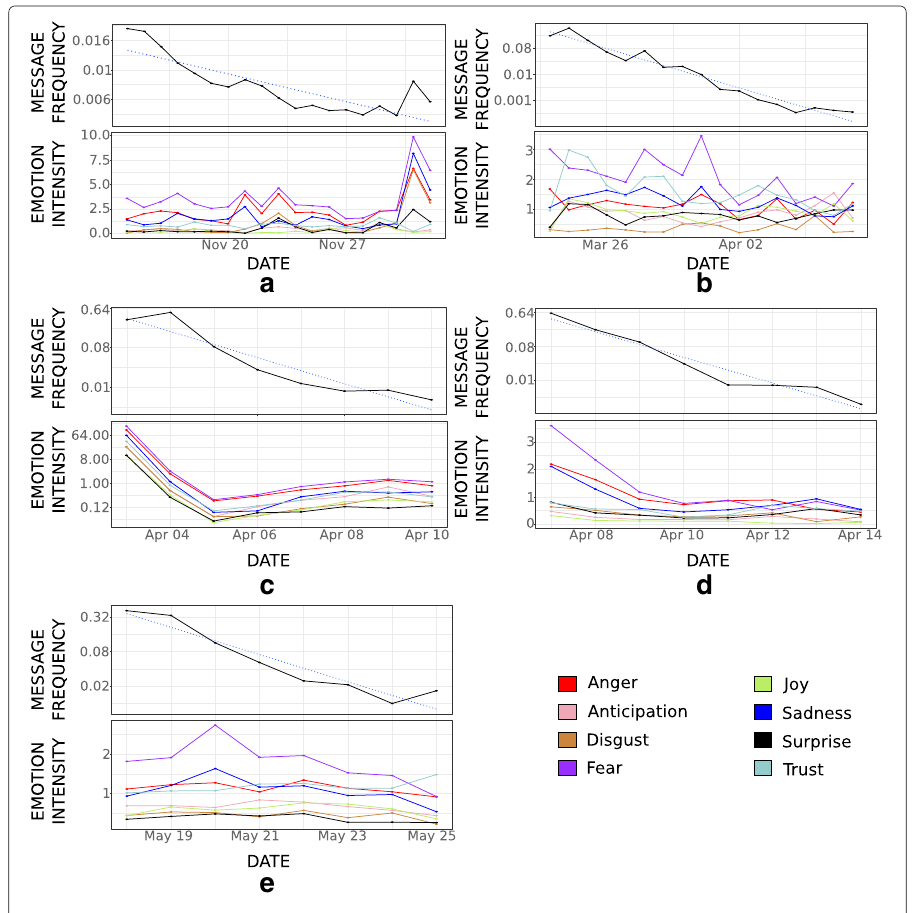
Fig. 3 Temporal flow of messages and emotions. Number of messages per day (message flow frequency) is normalized within the interval [0,1] and plotted with its corresponding regression line (dashed blue line). Daily emotion intensity is averaged over the total number of messages per day. a Tehama County shooting b Trebes supermarket siege c YouTube shooting d Münster van attack e Santa Fe school